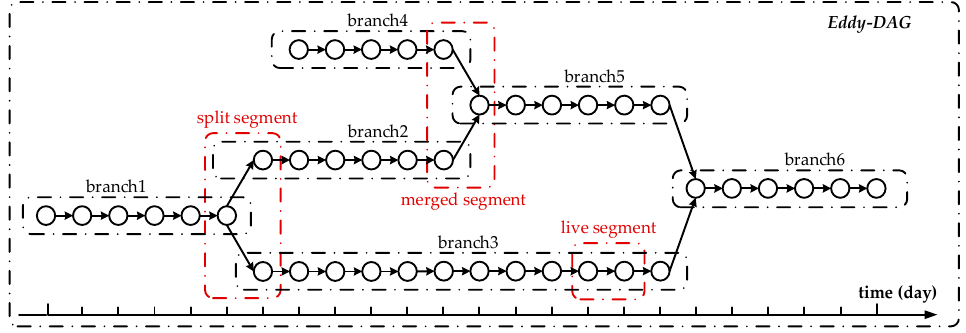
Figure 5. A diagram of a nonlinear Eddy-DAG consisting of splitting or merging branches with seg- ments as the basic units.